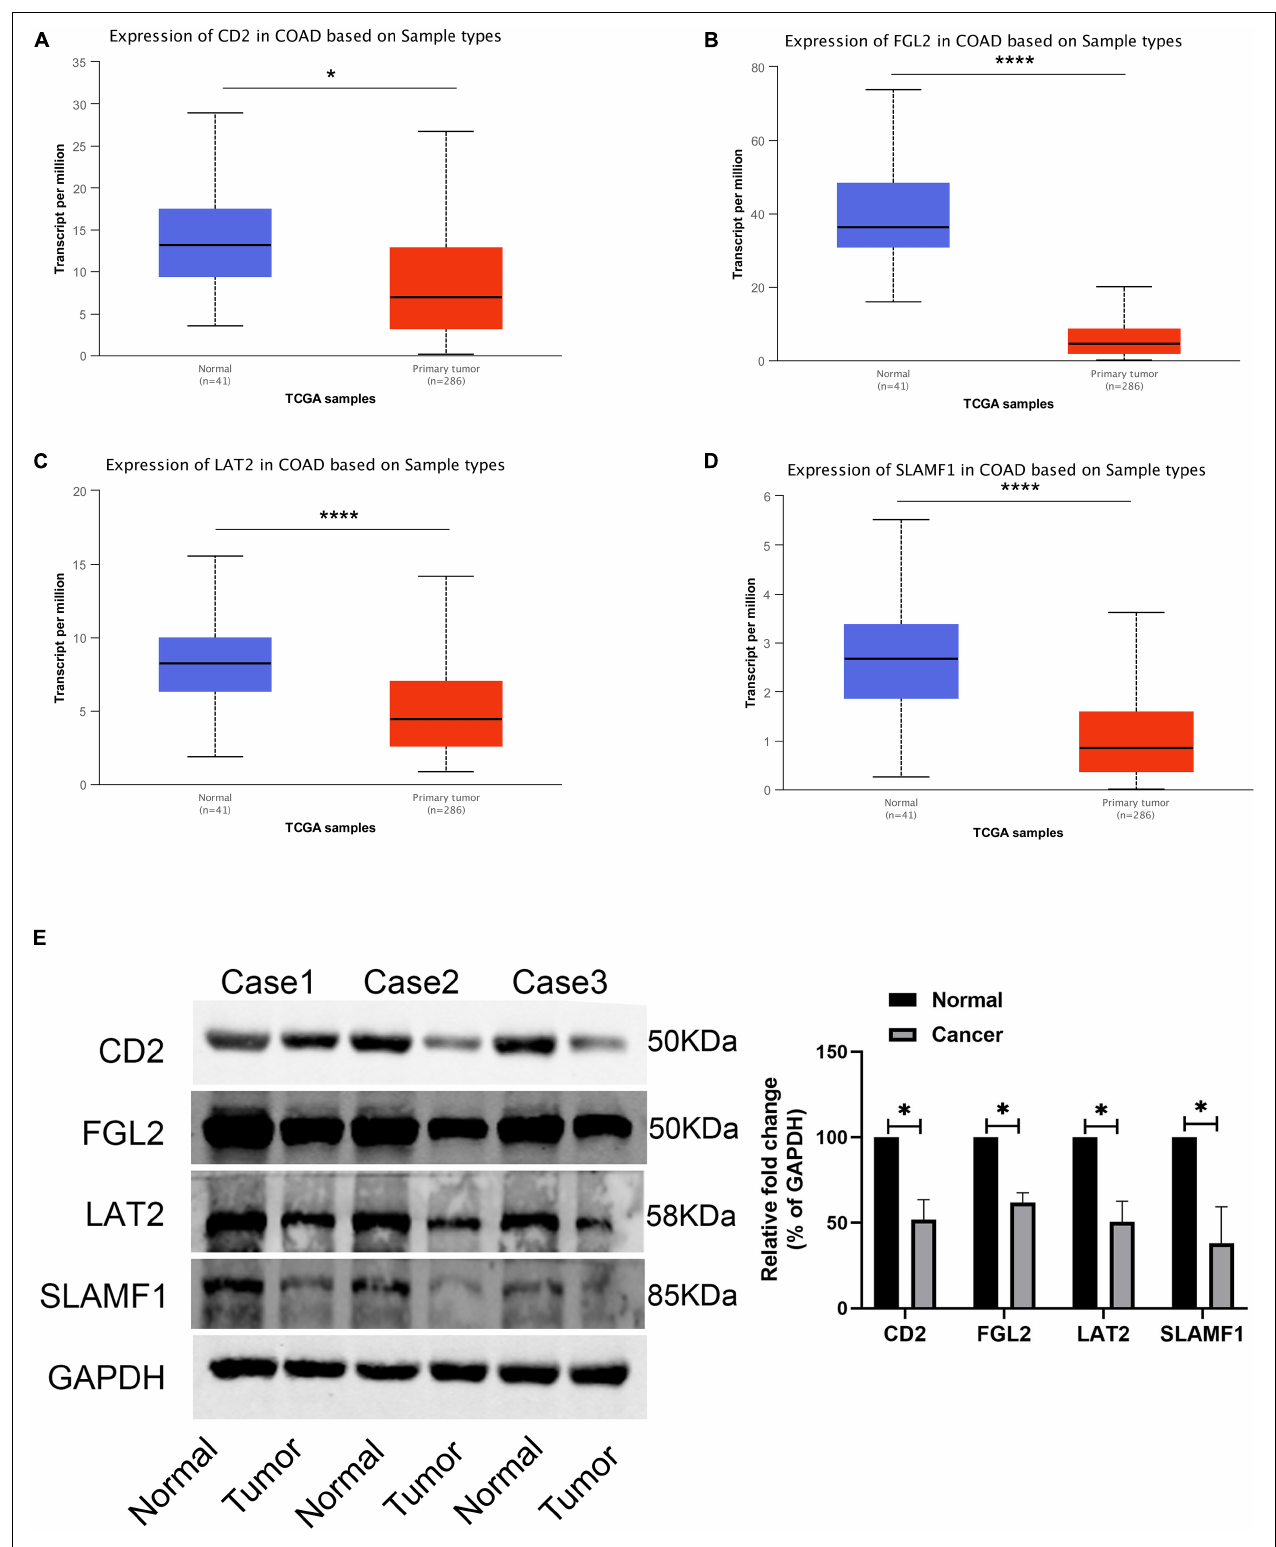
FIGURE 10 | Expression validation of four core genes. (A) The expression of CD2 in TCGA-COAD; (B) The expression of FGL2 in TCGA-COAD; (C) The expression of LAT2 in TCGA-COAD; (D) The expression of SLAMF1 in TCGA-COAD; (E) The expression of four hub genes in 3 paired COAD tissues and normal tissues. * P < 0.05 and **** P <